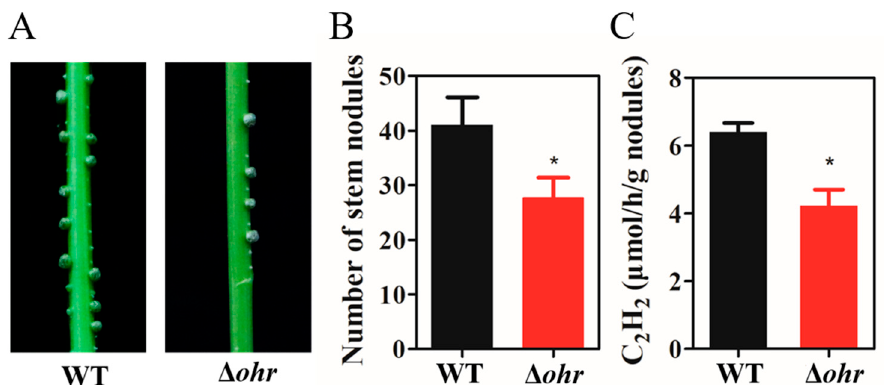
Figure 6. Symbiotic performance of A. caulinodans WT and ∆ ohr on S. rostrata . ( A ) Pictures of stem nodules formed by WT and ∆ ohr after 35 days post-inoculation. ( B ) The number of stem nodules on S. rostrata . ( C ) Nitrogen fixation activities of stem nodules. The values are means and standard deviations from six replicate plants. *: Student t -test P < 0.05.